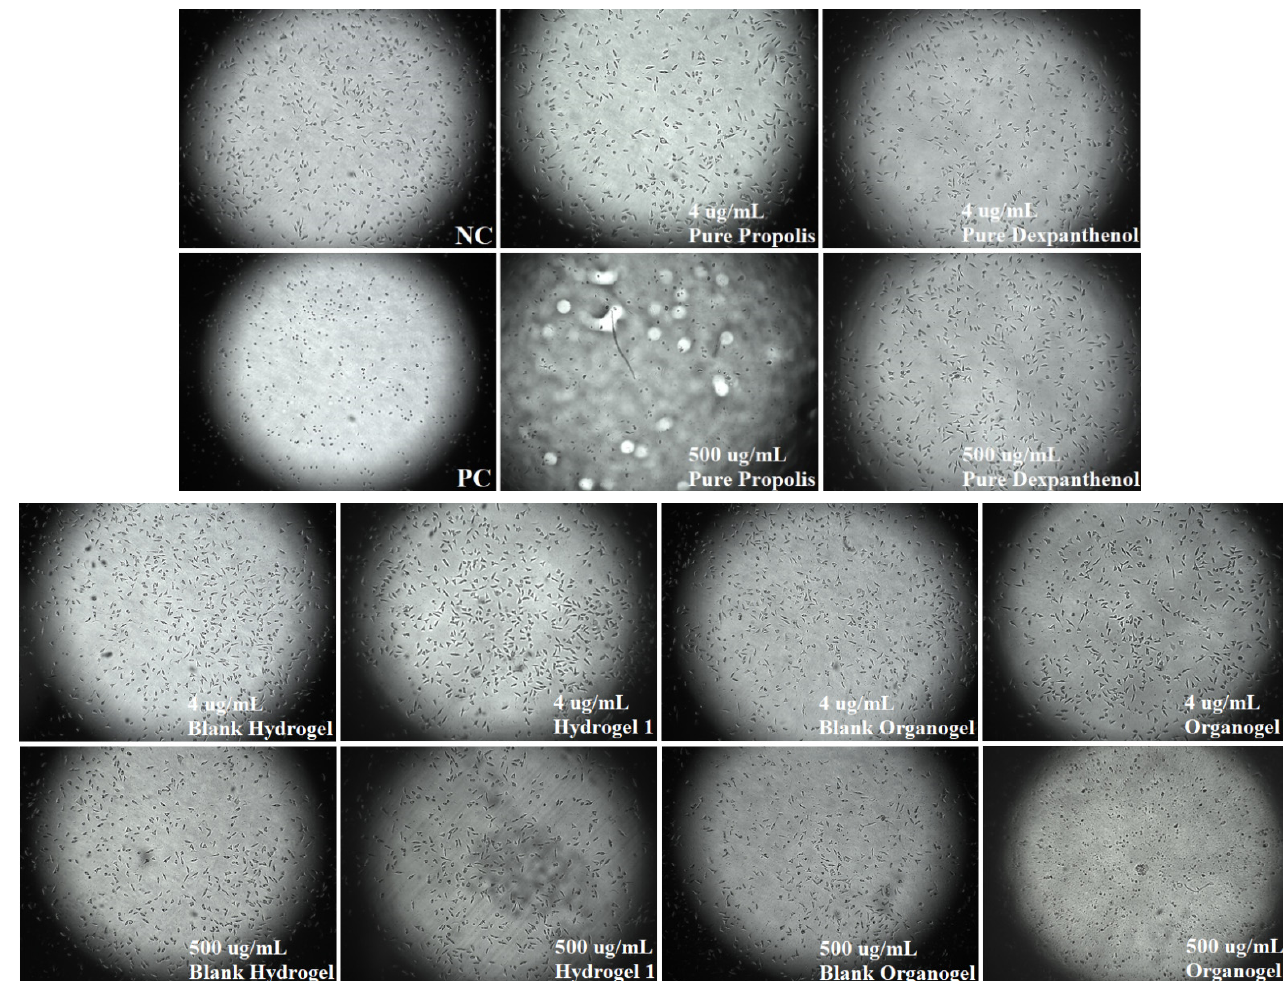
Figure 9. Cell morphology images of controls, pure propolis, pure dexpanthenol, hydrogels, and